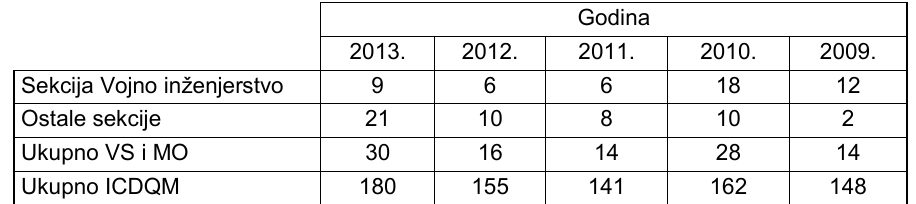
Pregled broja radova pripadnika VS i MO i ukupnog broja radova na ICDQM Number of papers of the participants from the Armed Forces and the MoD and the total number of conference papers Godina 2013.